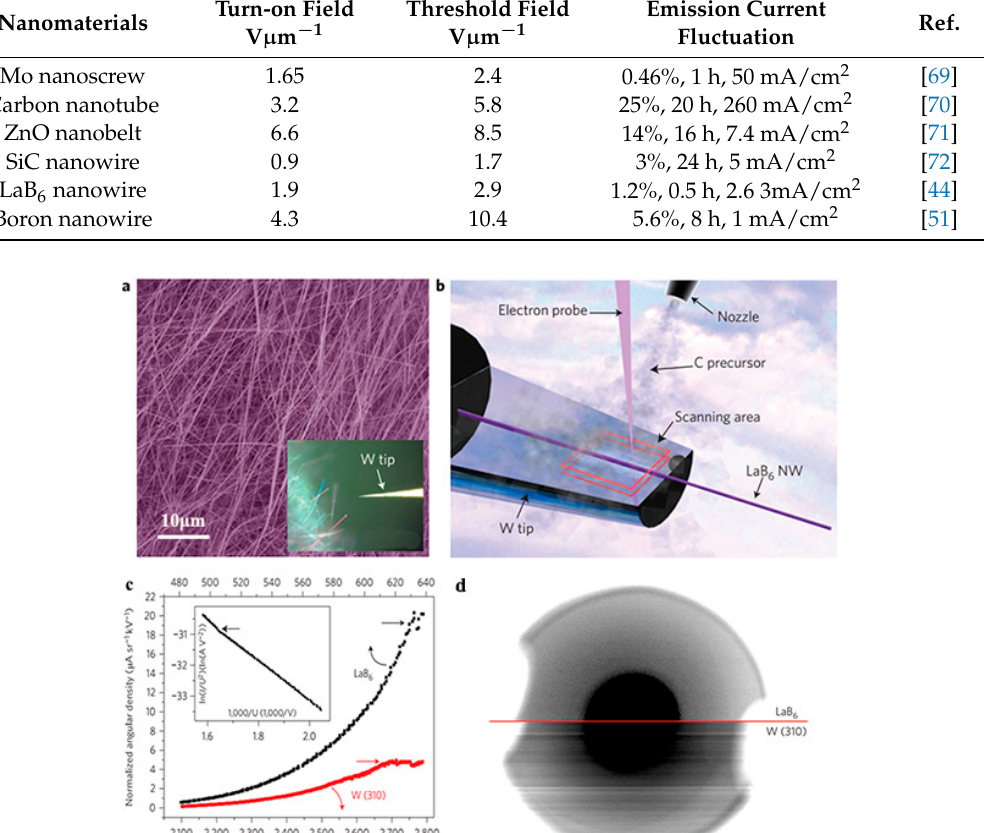
Table 3. Comparison table of the FE properties of some nanomaterials with excellent emission performances. Nanomaterials